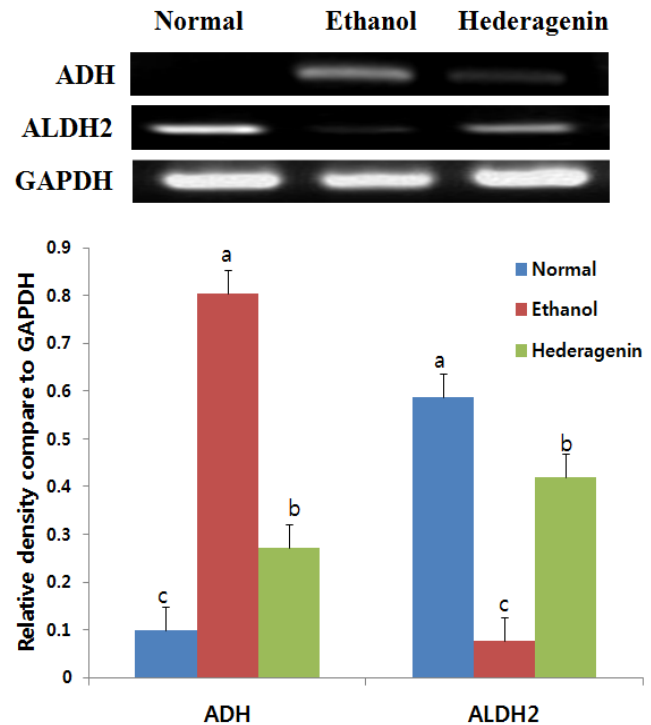
Figure 3. Effects of hederagenin on mRNA expression of ADH and ALDH2 assessed using RT ‐ PCR. Results are expressed as the means ± SD. Significant differences ( p < 0.05) are represented using different letters. ADH, alcohol dehydrogenase; ALDH, acetaldehyde dehydrogenase.